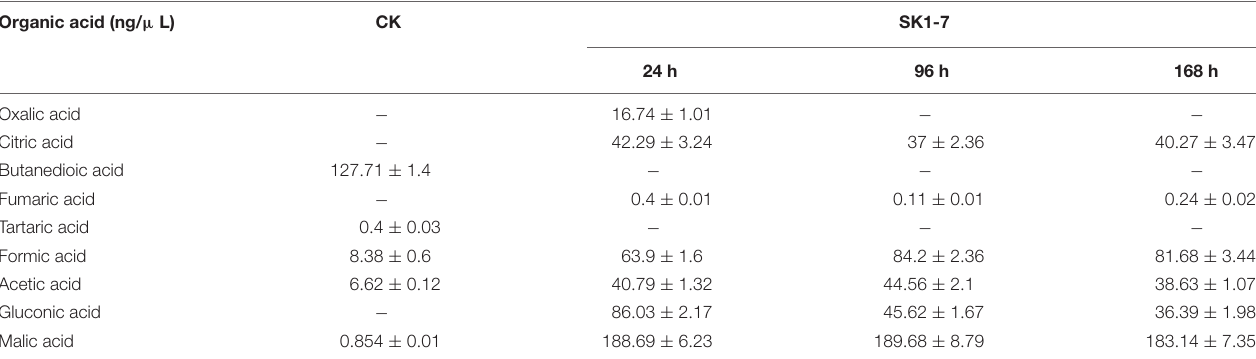
TABLE 5 | The organic acid contents in fermentation broth after B. aryabhattai SK1-7 inoculation. Organic acid (ng/ µ L)